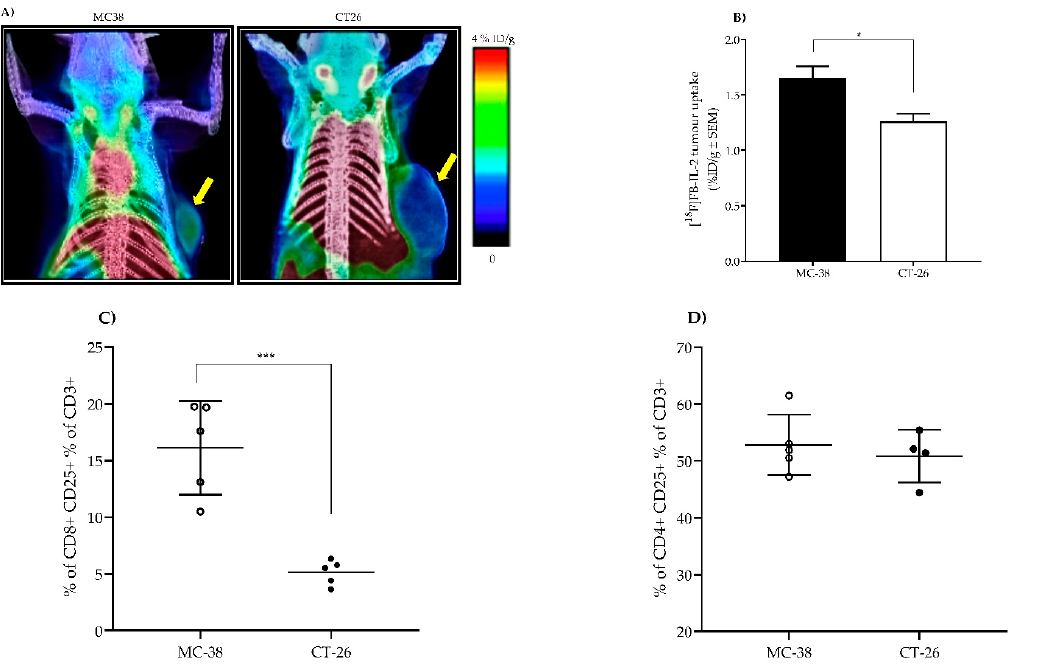
Figure 5. In vivo PET imaging of [ 18 F]FB-IL-2 in MC38 and CT26 tumour-bearing mice. ( A ) PET-CT fused image of mice with MC38 and CT26 tumours showing the distribution of [ 18 F]FB-IL-2. ( B ) Quantitative estimation of [ 18 F]FB-IL-2 uptake in MC38 tumours shows significantly higher uptake than in CT26 tumours (1.65 ± 0.24 vs. 1.21 ± 0.03, data shown as mean ± SEM % ID/g, * p < 0.05). ( C ) FACS analysis showing CD8+CD25+ cells as a % of CD3+ cells in MC38 and CT26 tumours. CD8+CD25+ cells were significantly higher in MC38 when compared to CT26 (16.12 ± 4.14 vs. 5.14 ± 1.09, *** p < 0.002, data shown as mean ± SD as a % of CD3+ cells). ( D ) FACS analysis showing CD4+CD25+ as a % of CD3+ cells in MC38 and CT26 tumours. No significant differences in CD4+CD25+ cells were observed between MC38 and CT26 (data shown as mean ± SD as a % of CD3+